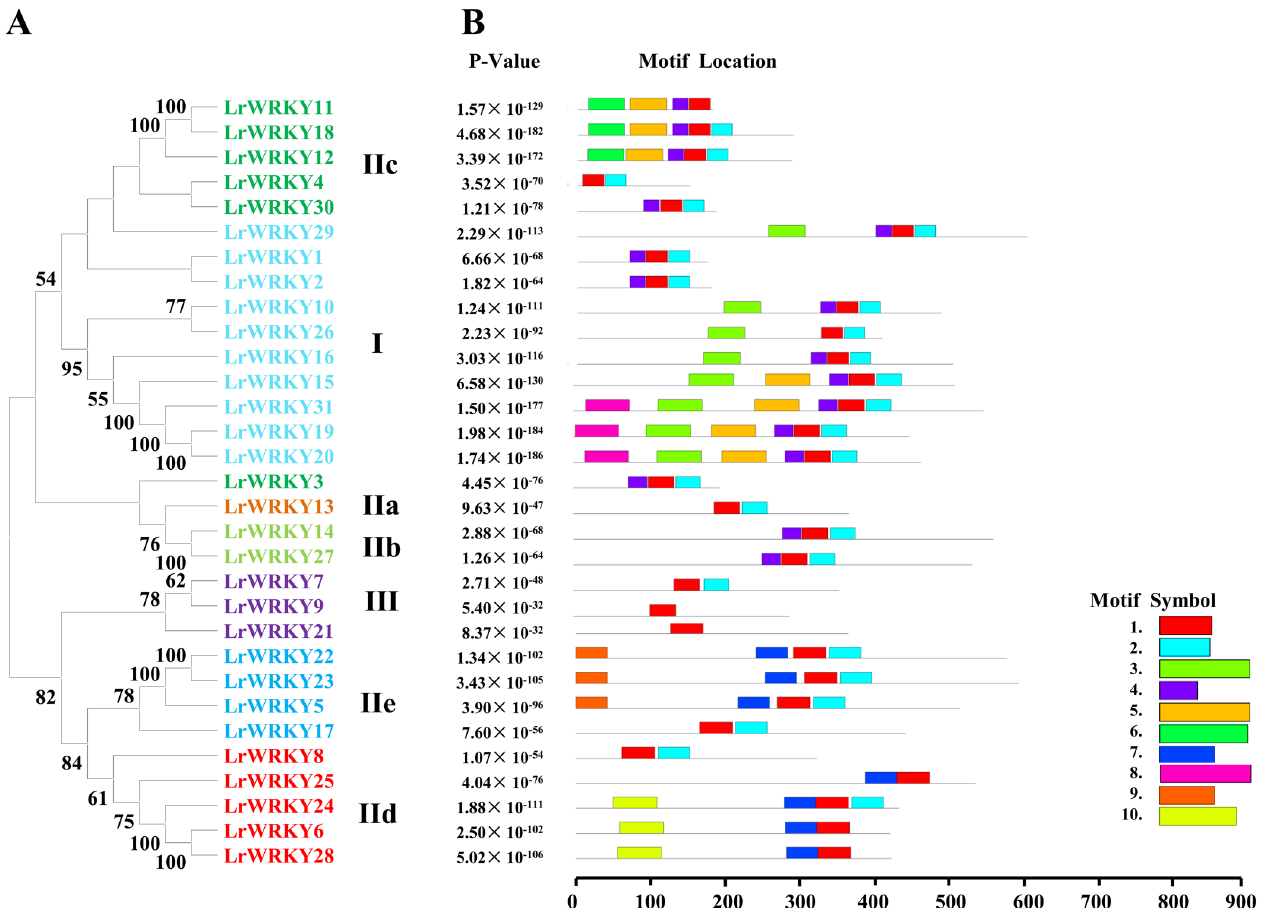
Figure 2. The phylogenetic relationships and conserved motifs analysis of LrWRKY proteins. ( A ) Neighbor-joining LrWRKYs phylogenetic tree (bootstrap values for 1000 replicates); ( B ) Conserved motif distribution in LrWRKY proteins. Different motifs are represented with different colored boxes. The motif length is represented by the box length.